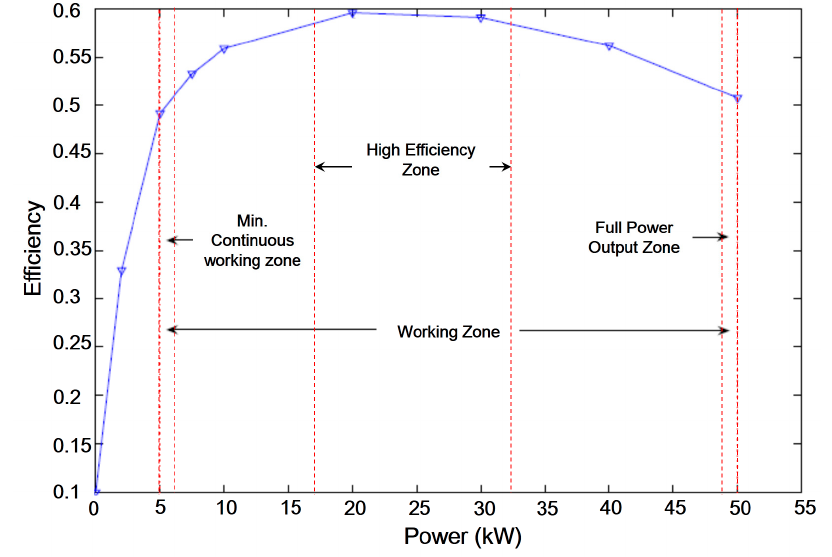
Figure 5. FCE working curve [18].